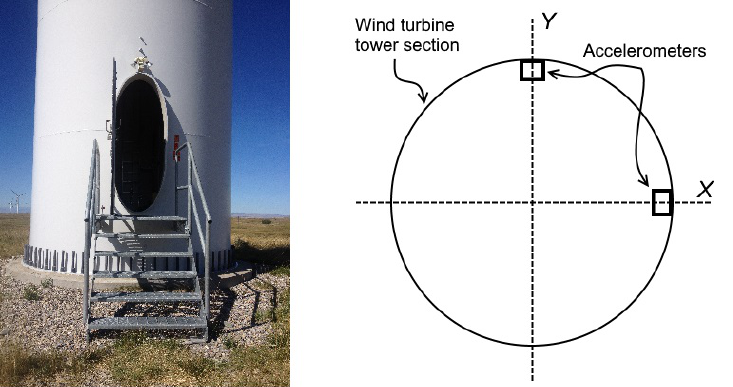
Figure 6. ( left ) 1.5 MW wind turbine tower; ( right ) schematic of the location of the accelerometers on the wind turbine